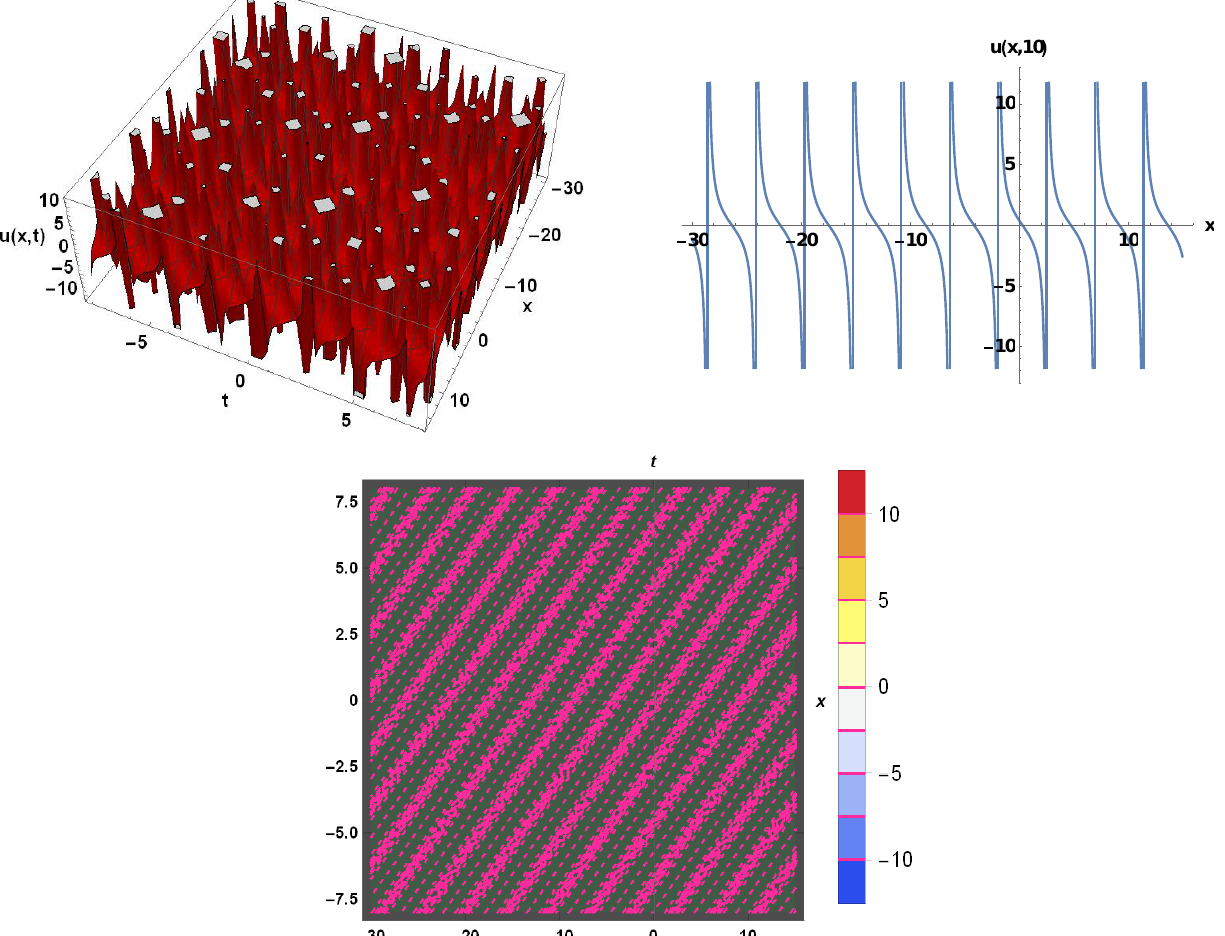
Figure 6. The solitary wave view of the 3D, 2D, and contour plots of U 6 ( x , t ).